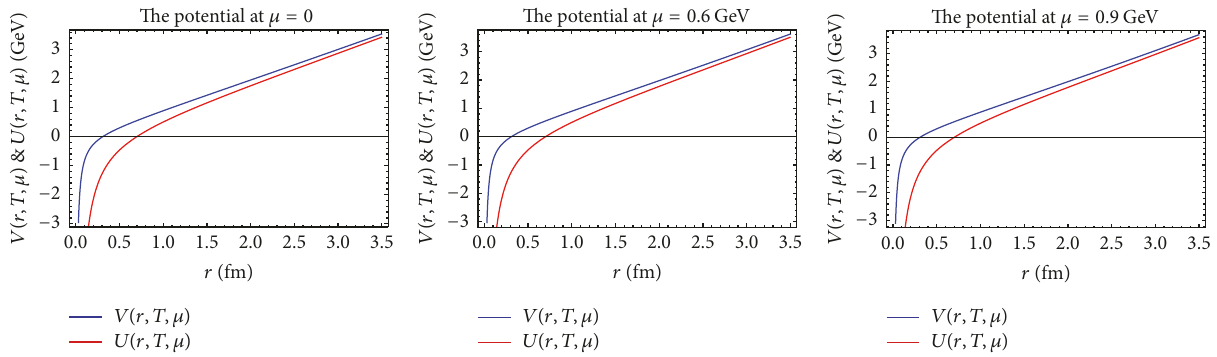
Figure 1: The comparison between the two potentials. The red line is the exact potential 𝑈(𝑟, 𝑇,𝜇) and the blue line is the approximate potential 𝑉(𝑟, 𝑇,𝜇) for different values of chemical potential at 𝑇 = 250 MeV.